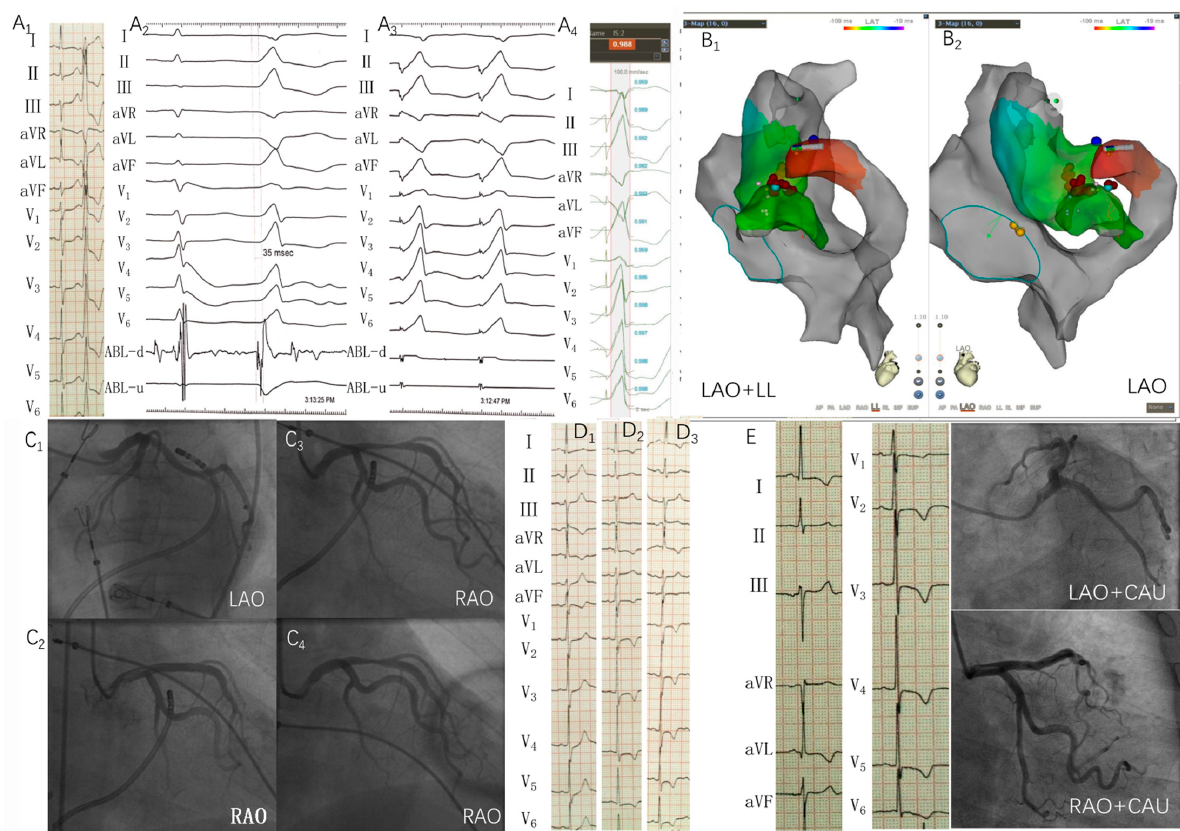
Figure 6. Example of ablation of IVAs originating from the Summit-CV. Epicardial mapping and ablation were performed in a 66 year-old woman with clinical IVAs. No structural heart disease was evident on echocardiography. Preoperative surface ECG (( A 1 ), activation mapping ( A 2 ) and pace mapping ( A 3 ) demonstrated rS wave on lead I, tall R wave on leads II, III, and aVF, and R wave in lead V 1 –V 6 . The local ventricular activation time recorded at Summit-CV preceded the onset of the QRS complex by 35 ms ( A 2 ) and pacing this site led to a 98.8% concordance with the QRS complex of IVA ( A 4 ). Activation mapping ( A 2 ) shows the intracavity bipolar electrogram (ABL-d) recorded from systolic high-amplitude potential to presystolic high-amplitude potential once mapping at ideal target site. ( B 1 , B 2 ) Electroanatomical map of the aortic sinus of Valsalva, the summit of the left ventricle, and Summit-CV. ( C 1 , C 2 ) show the fluoroscopic position of the ablation catheter site and coronary angiography (CAG). The middle segment of the left anterior descent branch (LAD) is located about 5.16 mm from the proximal edge of the ablation electrode at the ideal ablation site (note that the distal electrode of the ablation catheter is 2.67 mm [8-F] in diameter). Ablation was repeated with 43 °C, 25 W with an irrigation rate of 30 mL/min. The patient experienced temporary chest pain at 13s during ablation; immediate coronary angiography showed around 50% stenosis of the middle branch of the LAD ( C 3 ). Intracoronary nitroglycerin was given with incomplete response ( C 4 ), considering distal flow remained good, a stent was not inserted. Aspirin, clopidogrel, and isosorbide mononitrate were given after the procedure. ( D 1 – D 3 ) demonstrates changes in ECG in the following days. T wave voltage showed widespread decreases, and inverted T waves formed in lead I, aVL, and V 1 –V 6 . After 22 days, the patient experienced pericardial tamponade and was managed successfully by percutaneous pericardiocentesis and glucocorticosteroid treatment without further fluid reaccumulation. The patient remained asymptomatic from the coronary injury during 48 months of follow-up. Three years later, the patient presented with chest pain. Surprisingly, ECG still revealed inverted T waves in leads I, aVL, and V 1 –V 6 I; however, coronary angiography showed the middle segment of the LAD was patent ( E ).